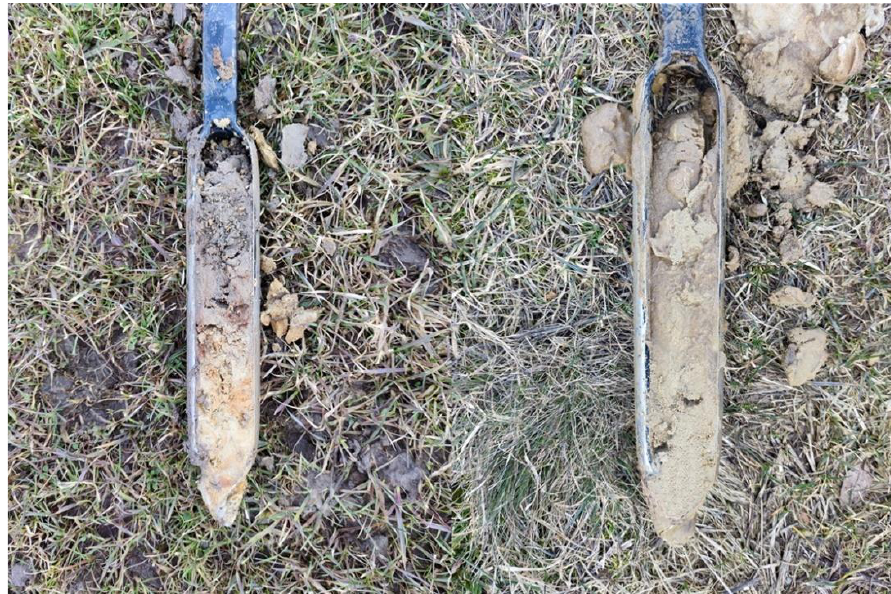
Figure 7. Soil samples from an example borehole.